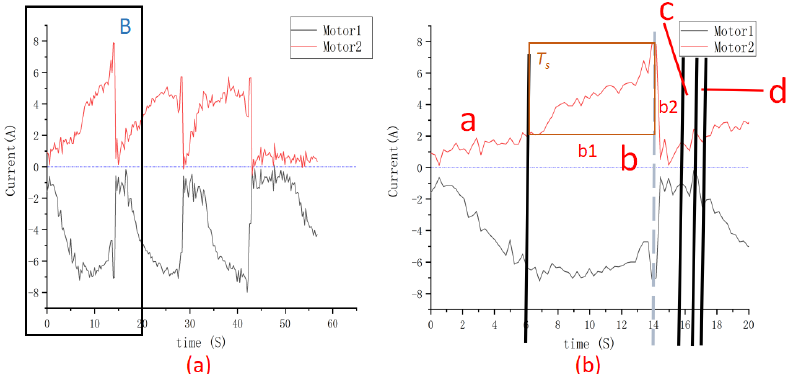
Figure 18. Current variation curves of the main drive motor for when the robot climbed the stairs: ( a ) the robot climbs the stairs for 57 s; ( b ) the amplification diagram of part B in Figure ( a ).